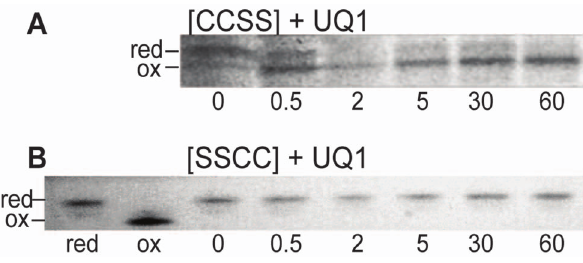
Figure 5. UQ1 interacts with the first periplasmic loop of a - DsbB. ( A ) UQ1 was able to fully oxidize a -DsbB [CCSS] within 2 min; ( B ) UQ1 did not oxidize a -DsbB [SSCC]; lanes marked ‘‘red’’ and ‘‘ox’’ lanes indicate samples of reduced and oxidized a -DsbB [SSCC], respectively. Data shown are representative of two replicates.